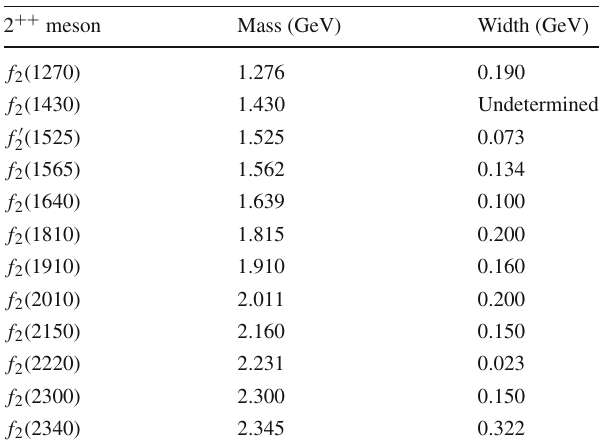
Table 2 List of light J PC = 2 ++ and I = 0 mesons as